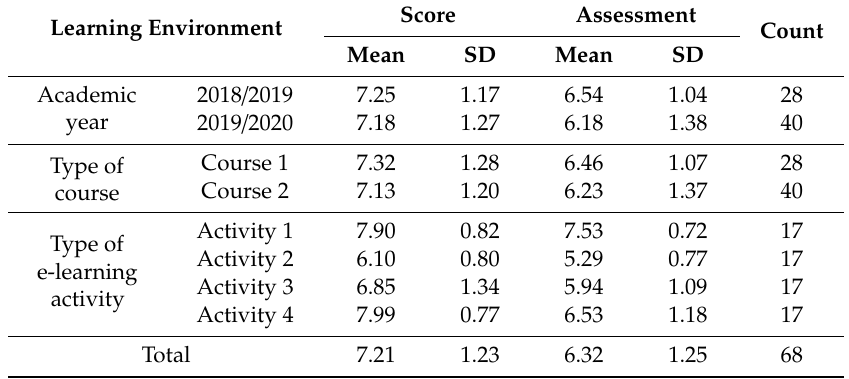
Table 3. Mean and standard deviation (SD) values for each variable, category and factor